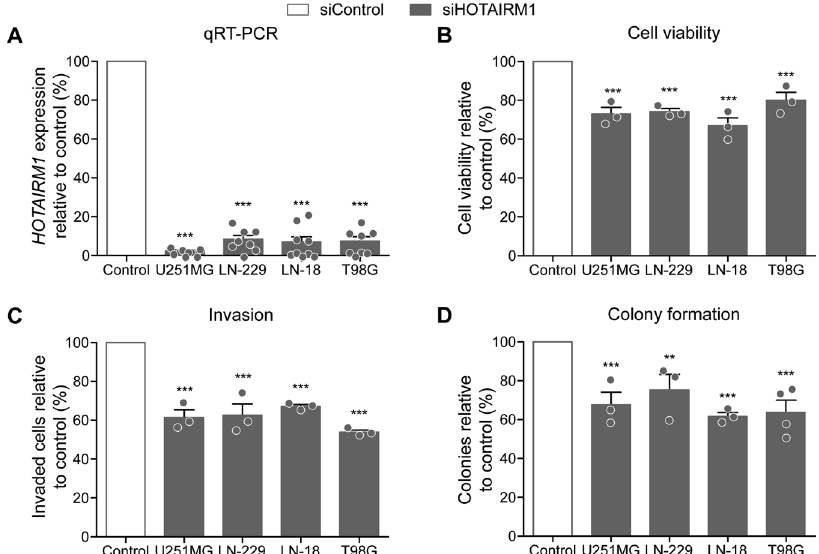
Fig. 2 HOTAIRM1 knock-down decreases oncogenic features in glioblastoma cell lines. siRNA-mediated knock-down was achieved using siPOOLS (siTOOLs Biotech, Planegg, Germany). A qRT-PCR was performed using TaqMan probes against HOTAIRM1 or phosphoglycerate kinase 1 ( PGK1 ) as a housekeeping control gene. Following HOTAIRM1 knock-down, the four investigated glioma cell lines showed reduced cell viability as determined with the CellTiter-Glo assay ( B ), reduced invasiveness measured in Boyden chamber assays ( C ), and, fi nally, decreased clonogenicity as determined by colony formation assays after seeding cells at a density of 500 (U251MG and LN-18) to 1000 (LN-229 and T98G) cells per 10 cm dish ( D ). White bars indicate the results of the respective control-transfected cells set to 100%. Filled bars are results obtained with HOTAIRM1 knock-down cells. siControl: cells transfected with non-target siPOOLS; siHOTAIRM1: cells transfected with siPOOLS against HOTAIRM1 . Two-way ANOVA was used for statistical analyses; mean ± SEM, *** p < 0.001, ** p < 0.01. n = 4 independent experiments for the colony formation assays for T98G cell line, n = 3 independent experiments per cell line and